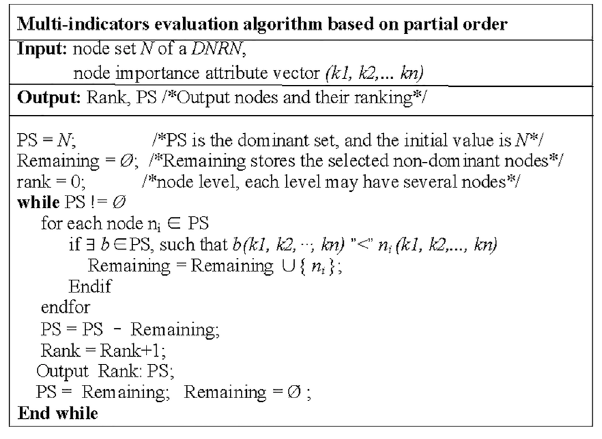
FIGURE 6 | multi-indicators evaluation algorithm based on partial order.